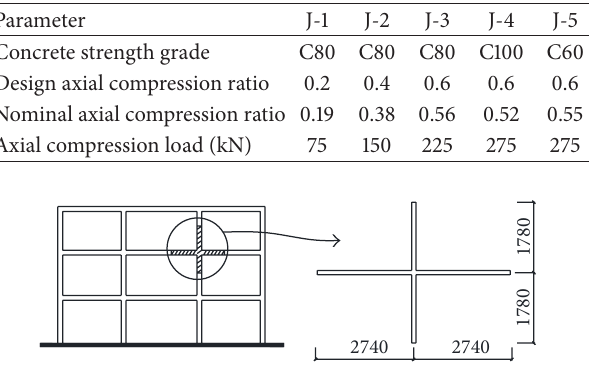
Figure 1: Description of prototype